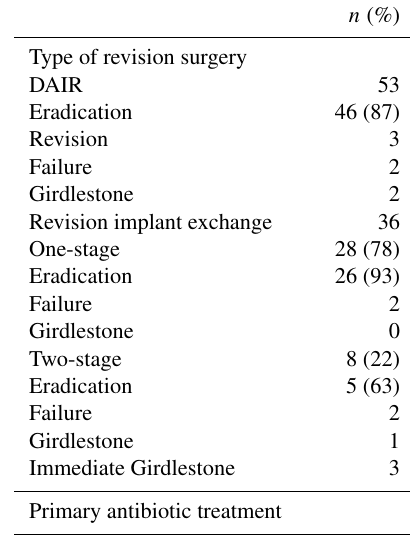
Table 4. Summary of revision procedures in hematogenous and postoperative periprosthetic joint